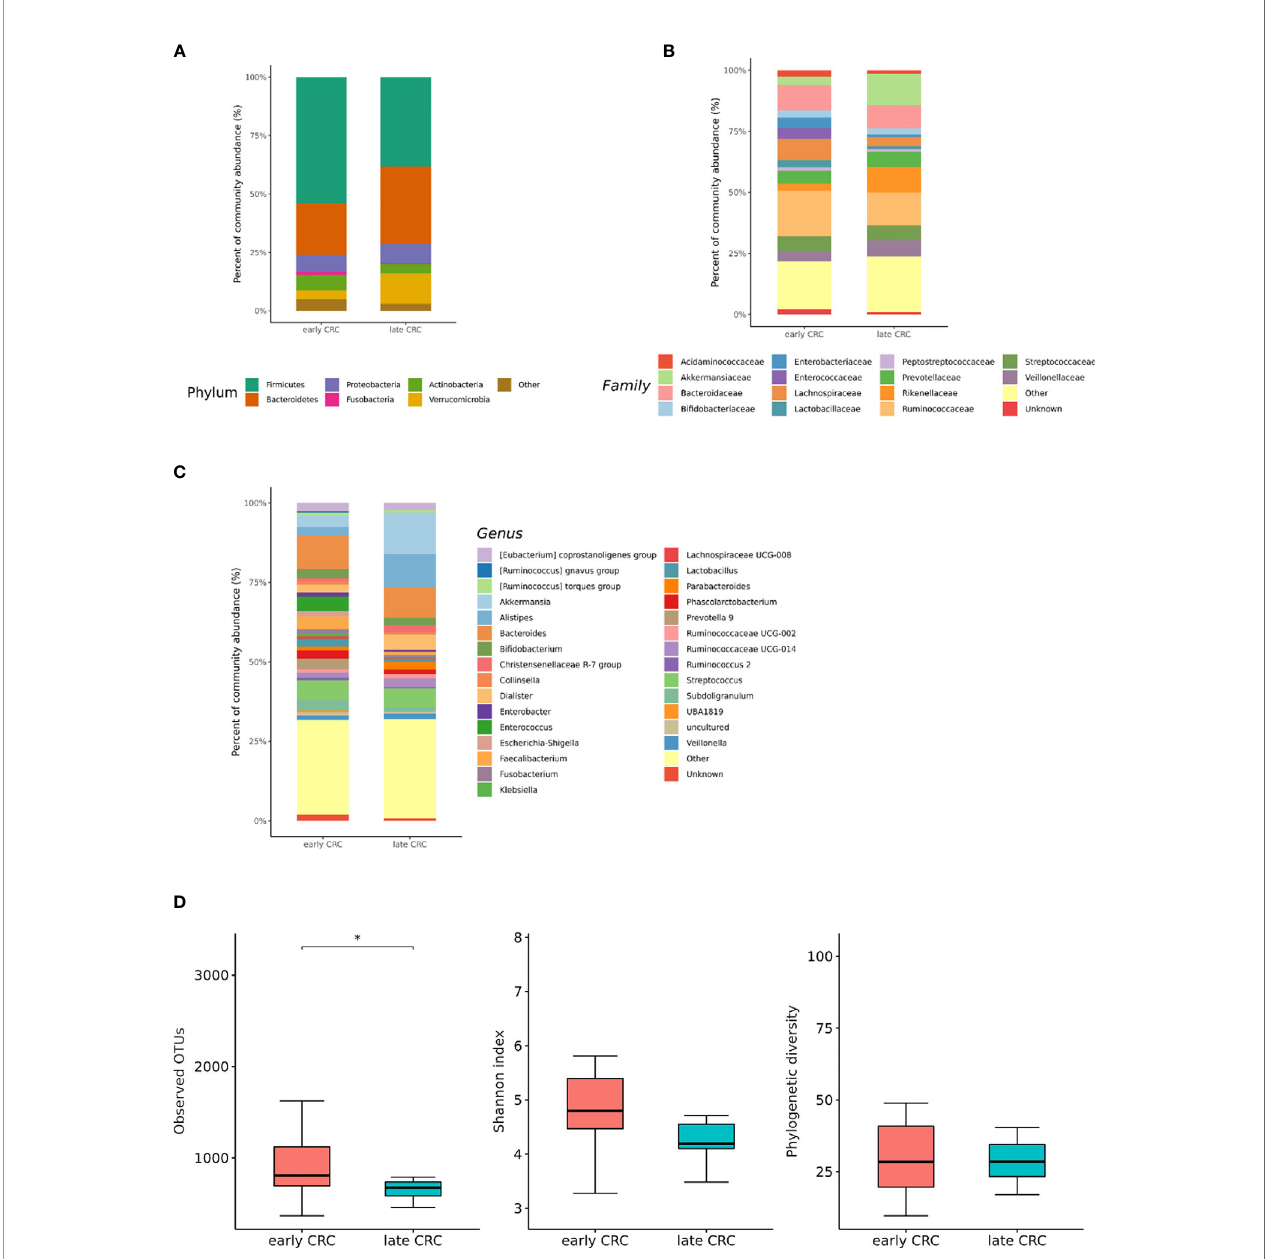
FIGURE 5 | Relative abundance plots of the gut microbiota of early CRC (n = 62) and late CRC (n=8) (A) at the phylum, (B) family, and (C) genus levels. (D) Boxplots of alpha diversity indices comparing late CRC with early CRC in the gut microbiota. * p < 0.05. CRC; colorectal cancer, OTU; operational taxonomic